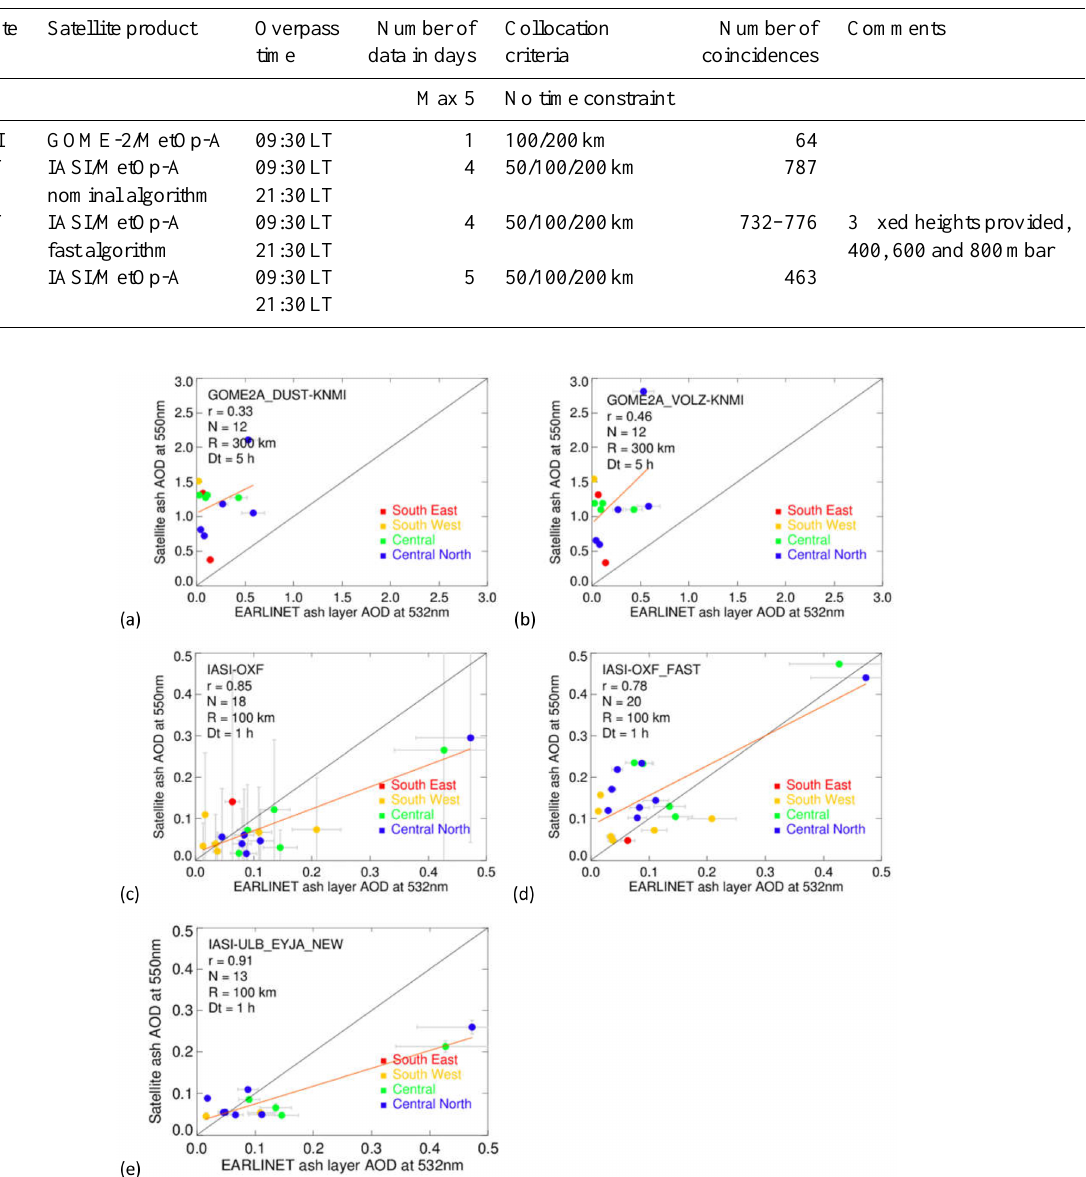
Table 3. Collocation criteria examined in the aircraft–satellite comparisons. The flights were performed between 13:00 and 17:30UTC.